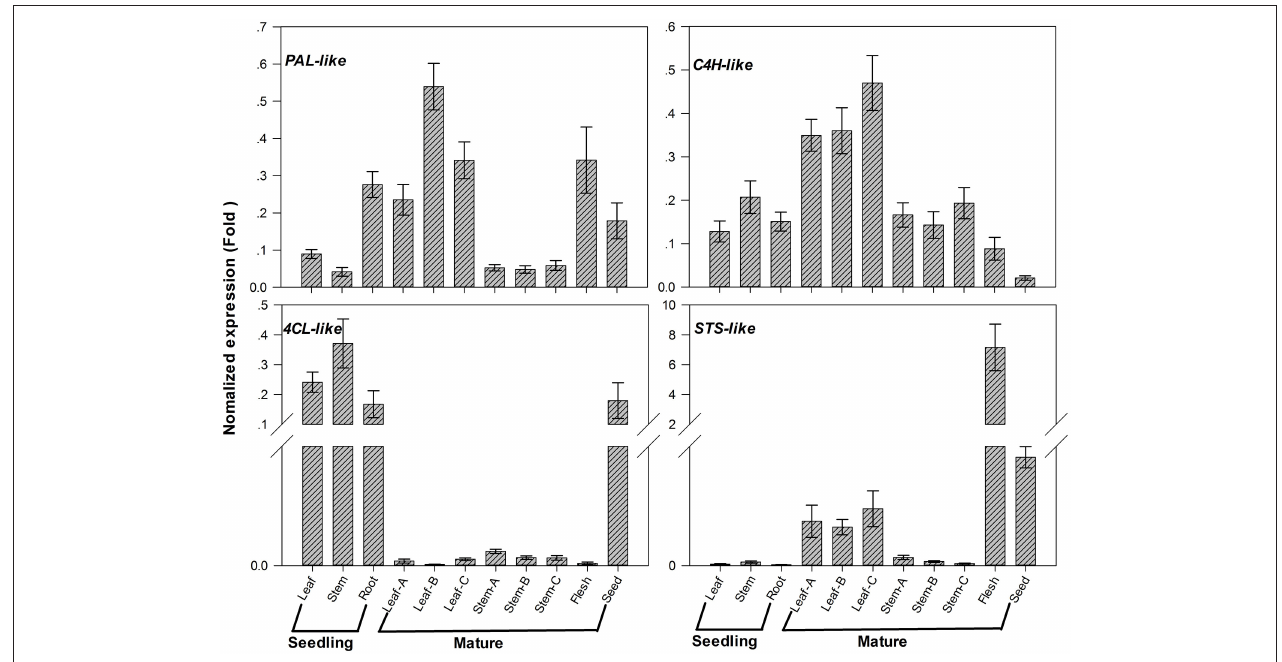
FIGURE 6 | Expression patterns of candidate genes involved in stilbenoids biosynthesis in different tissues from Gnetum parvifolium . Vertical bars represent the mean ± SD of four separate experiments. In figure, Leaf, Stem, and Root were collected from 1-year old seedlings; Leaf/Stem-A, -B, and -C were three stages of leaves/stem from young to old, respectively, collected from mature trees in September; Flesh and Seed were fruit flesh (aril) and seeds, respectively. PAL-like : comp81110_c0; C4H-like : comp90938_c0; 4CL-like : comp94230_c0; STS-like : comp550004_c0.